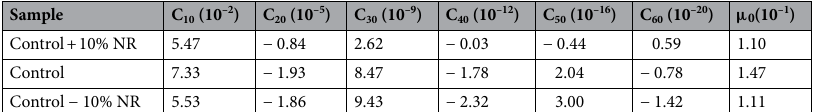
Table 3. Modelling parameters from the 1st to 6th order of the reduced polynomial for the foam samples.